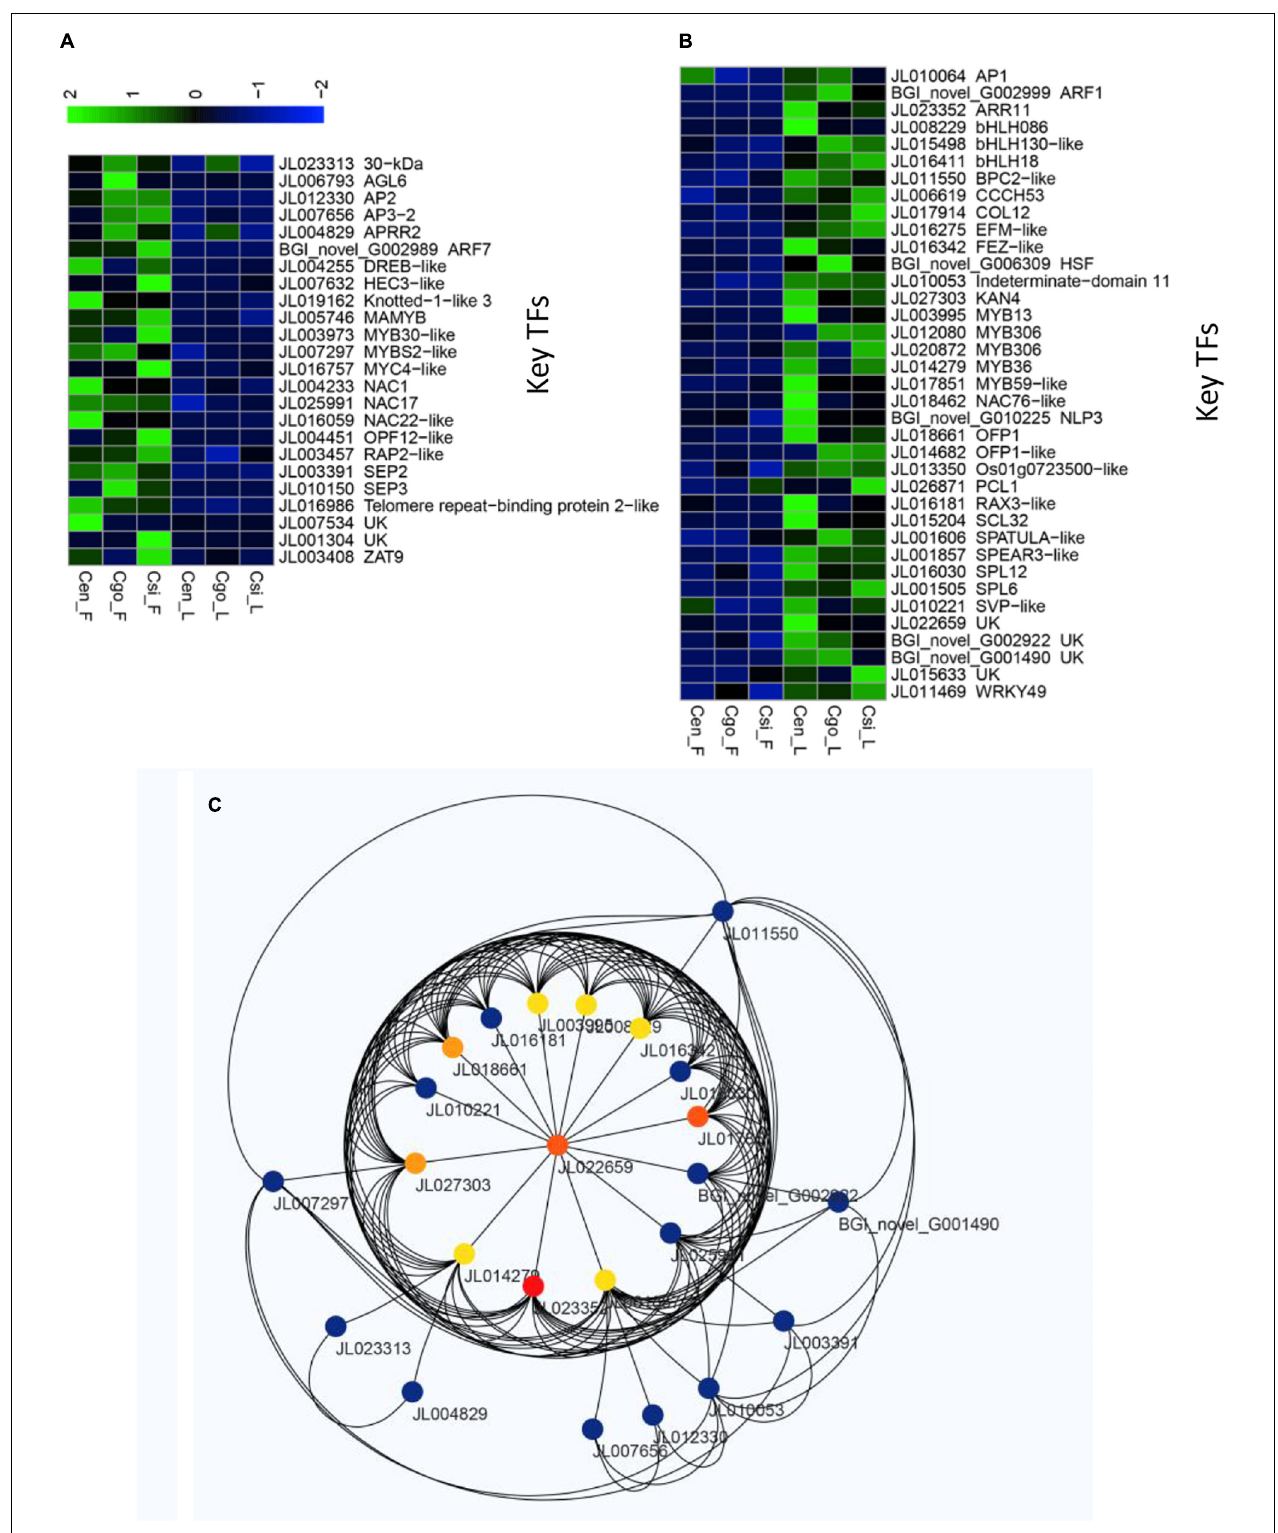
FIGURE 7 | Sets of highly differential TFs among flowers and leaves of the three orchid species, including upregulated only in the flowers (A) and upregulated only in the leaves (B) ; and the network formed by the flower and leaf specific TFs (C) .